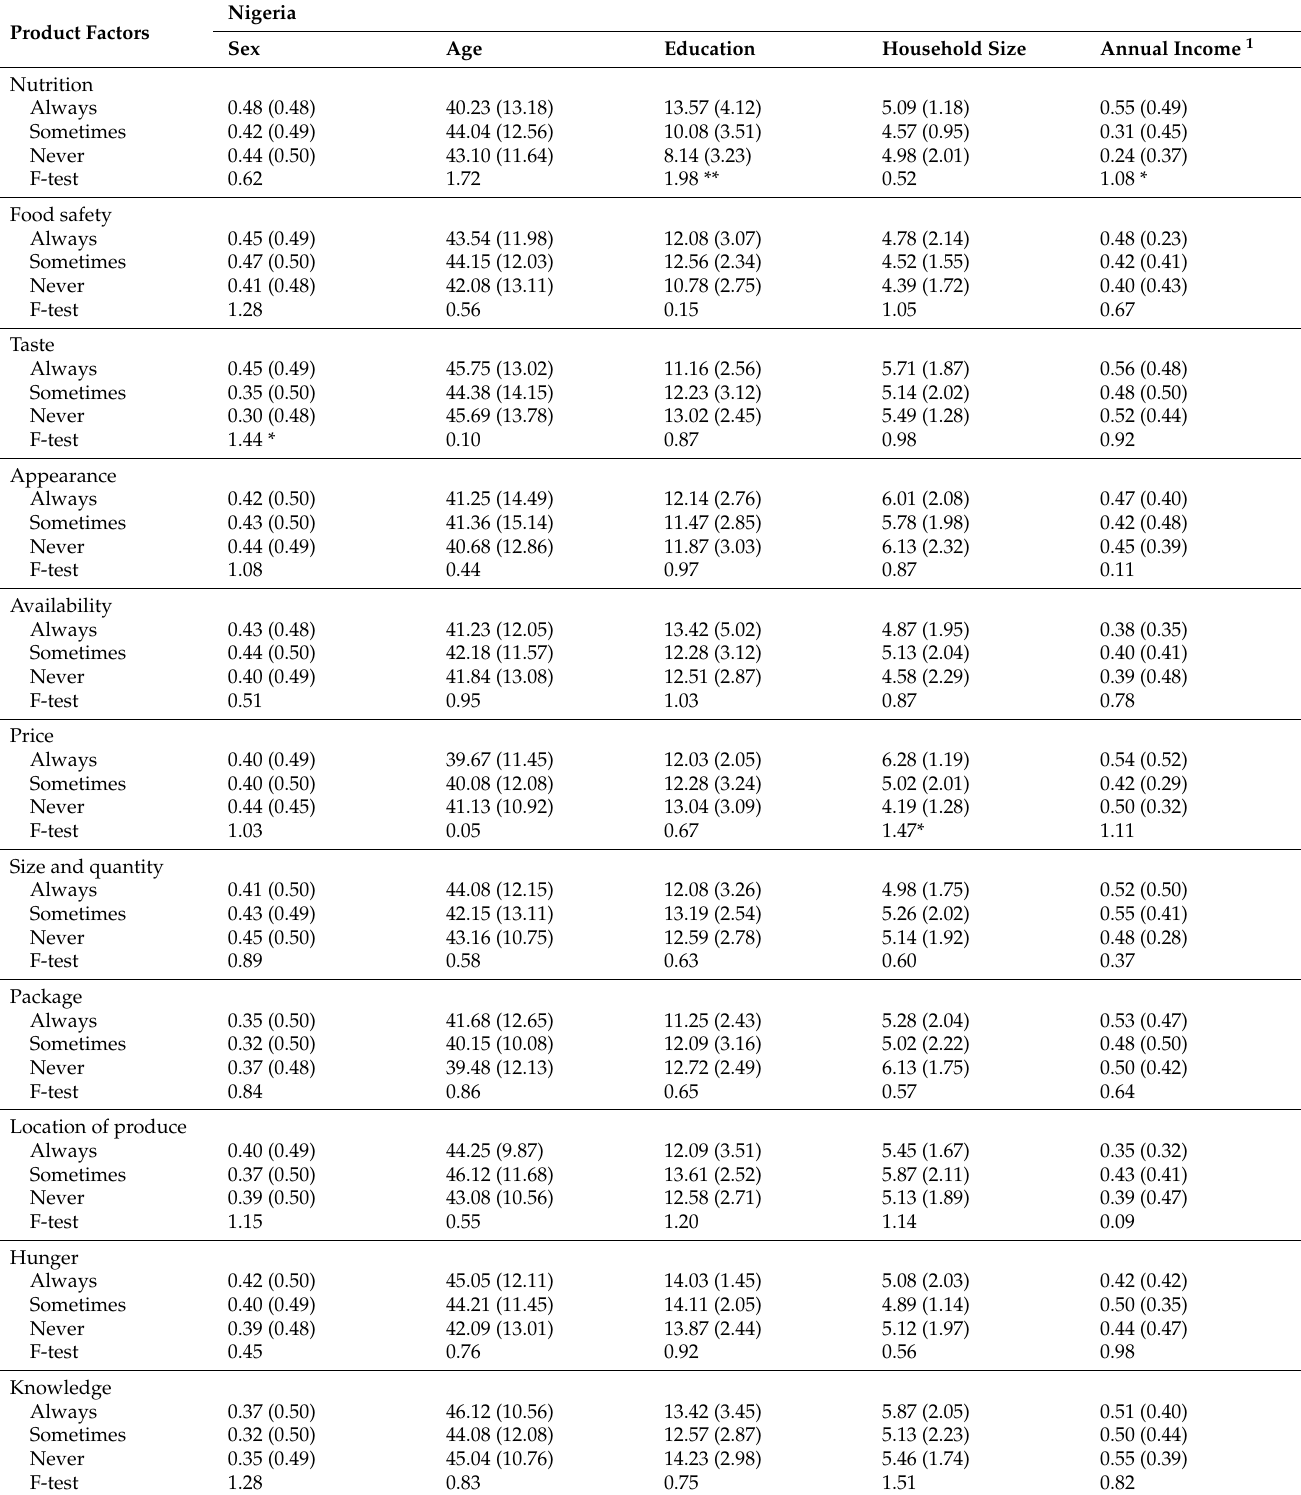
Table 5. Factors determining consumers’ choices for consumption of plantain-based products in